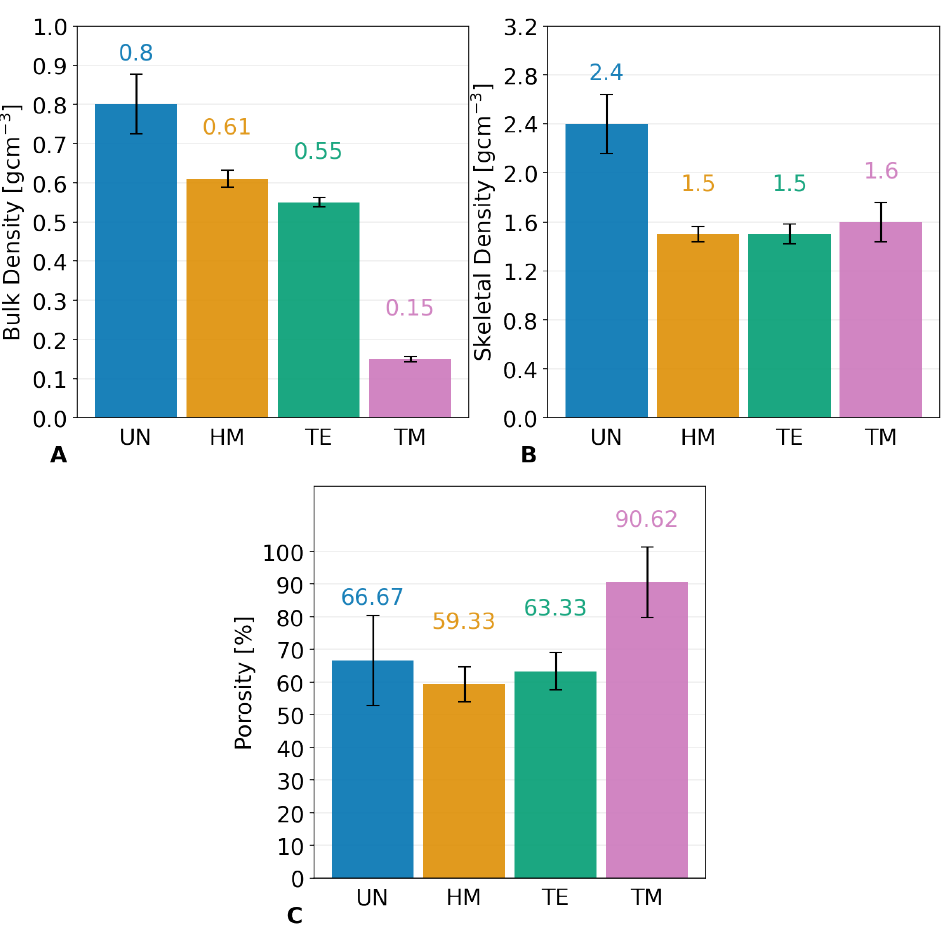
Figure 6. The samples as they appear in the Dragonfly software after segmentation. From left to right, the unmodified UN, hexamethyldisilazane-modified HM, triethylchlorosilane-modified TE, and trimethylchlorosilane-modified TM samples are shown. One dataset from each surface modifi- cation batch was selected. Additionally, a scale bar was added for the TE sample for visualization.